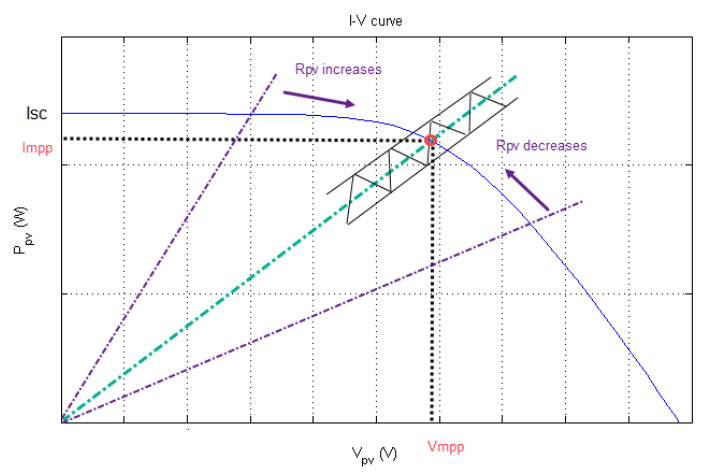
Figure 5. I–V characteristic